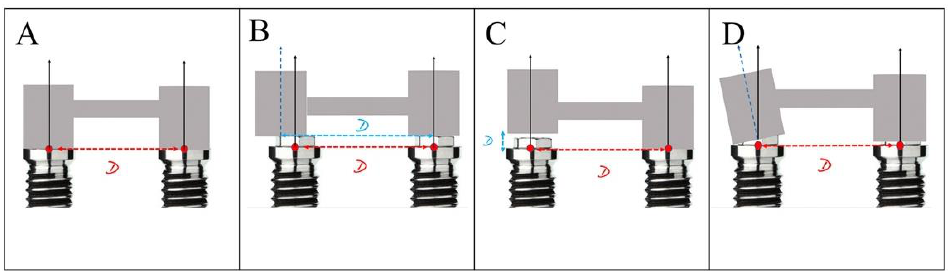
Figure 3. Representation of fit of suprastructure over two implants. ( A ) Ideal passive fit. ( B ) Misfit due to deviation on X axis between abutments. ( C ) Misfit due to deviation on Y axis between abutments. ( D ) Misfit due to variation of angulation between abutments, depending on the number of abutments involved in each prosthetic structure.